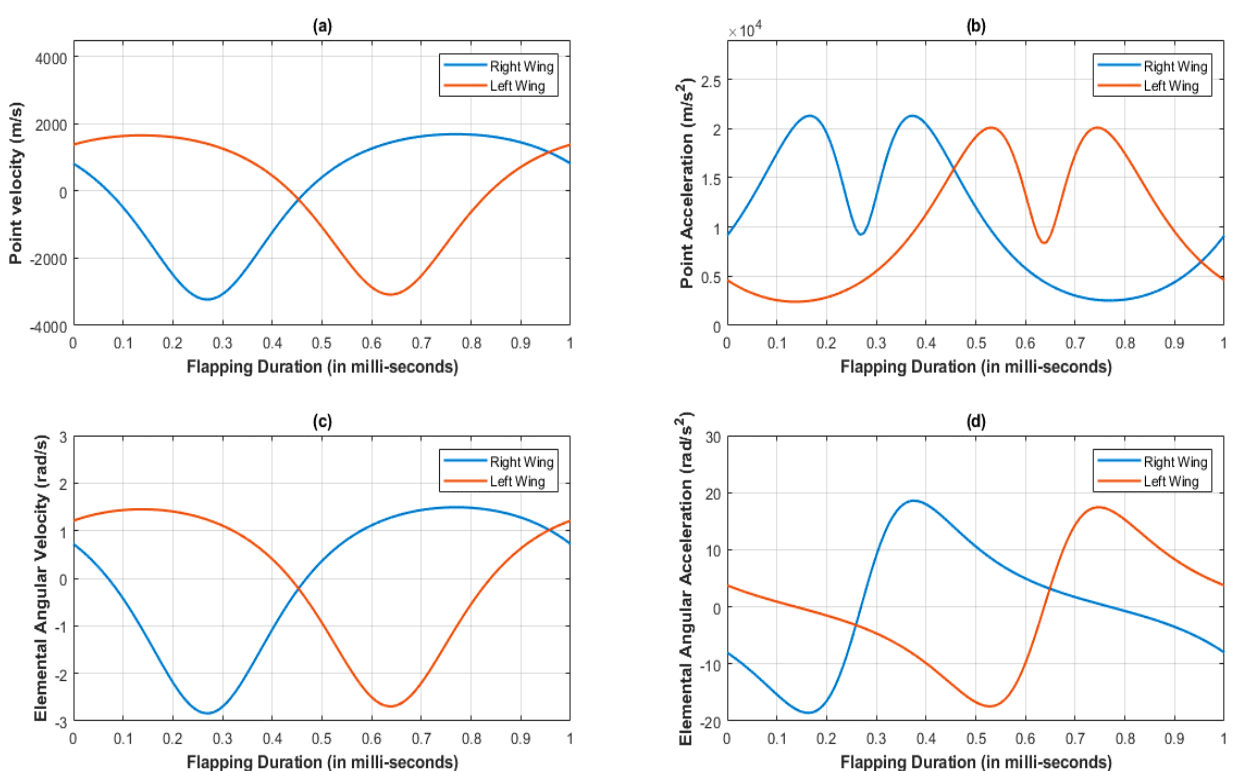
Figure 5. Kinematic analysis at lever tip of the SC-SDL design mechanism-I; ( a ) Point velocity vs. Flapping Duration; ( b ) Point Acceleration vs. Flapping Duration; ( c ) Elemental Angular velocity vs. Flapping Duration; ( d ) Elemental Angular Acceleration vs. Flapping Duration.